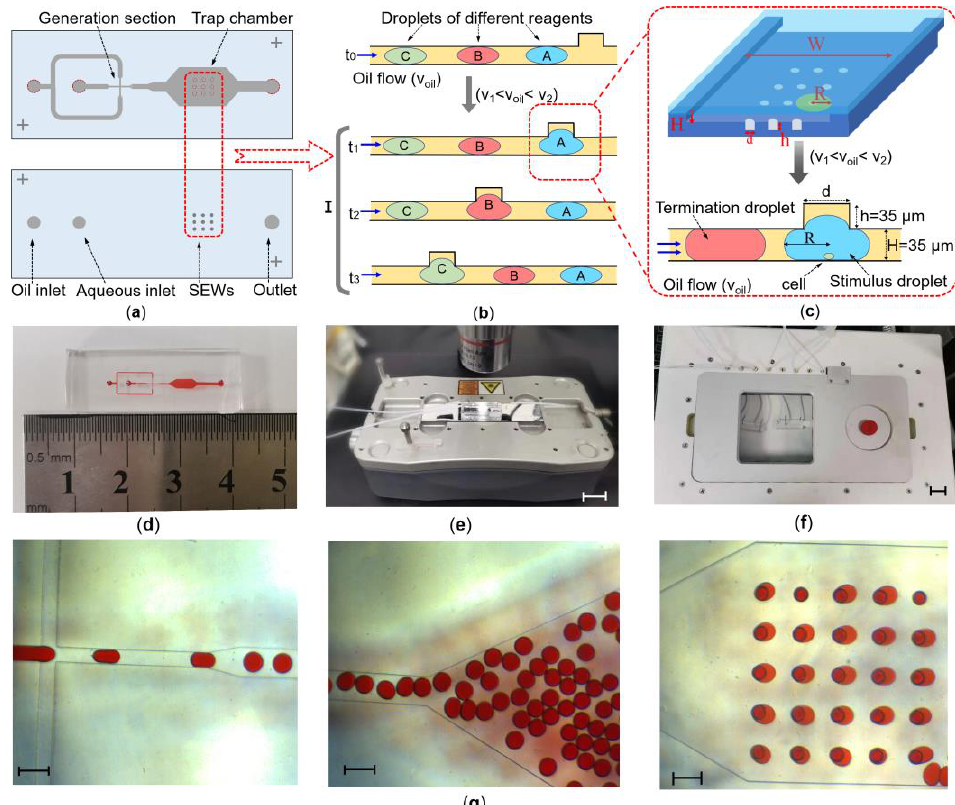
Figure 1. ( a ) Chip design: schematic top view of the microfluidic chip showing the layout of the bottom and top plasma-bonded layers, featuring dual inlets for two-phase flow. The bottom layer comprises the generation section with a flow-focusing junction and a trapping chamber. The top layer is composed of an SEW array, outlet, aqueous liquid and oil inlets for droplet generation and flow rate control. ( b ) Replacement mode: schematic side view of droplets being trapped under the SEW structure due to reduced surface energy. With an increase in the oil flow rate, the trapped droplet (reagent A) is replaced by the oncoming droplet (reagent B), and the sequence is repeated to replace droplet B with droplet C. ( c ) Side-view schematic showing adherent single cells cultured on the bottom layer under the SEWs. The cells were probed for protein phosphorylation with high spatiotemporal control: the ligand droplet (blue) becomes trapped by the SEW, thereby covering the cells for several seconds, followed by replacement by the termination droplet (red). ( d ) Image of the assembled chip filled with red ink. ( e ) Dolomite equipment comprising pressure pumps for microfluidic chip operation and a high-speed digital microscope for observation. ( f ) Bench incubator used for loading cells onto the microfluidic chip and incubation. ( g ) Sequential high-speed microscope images of red ink droplets being generated, delivered to the trapping chamber and trapped (left to right). Scale bars: 200 µ